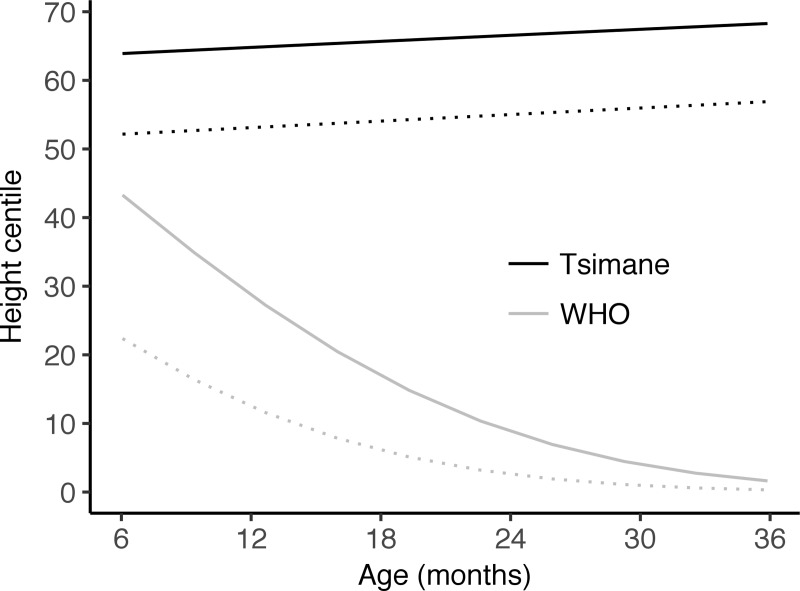
Predicted WHO- and Tsimane LMS-derived height centiles by age and CF status.Predicted values derived from Models 8a-b. Black lines = centiles predicted from Tsimane LMS curves; grey lines = centiles predicted from WHO LMS curves (for both sets, solid = introduced CF at 0–3 months, dashed = introduced CF at 4–5 months).